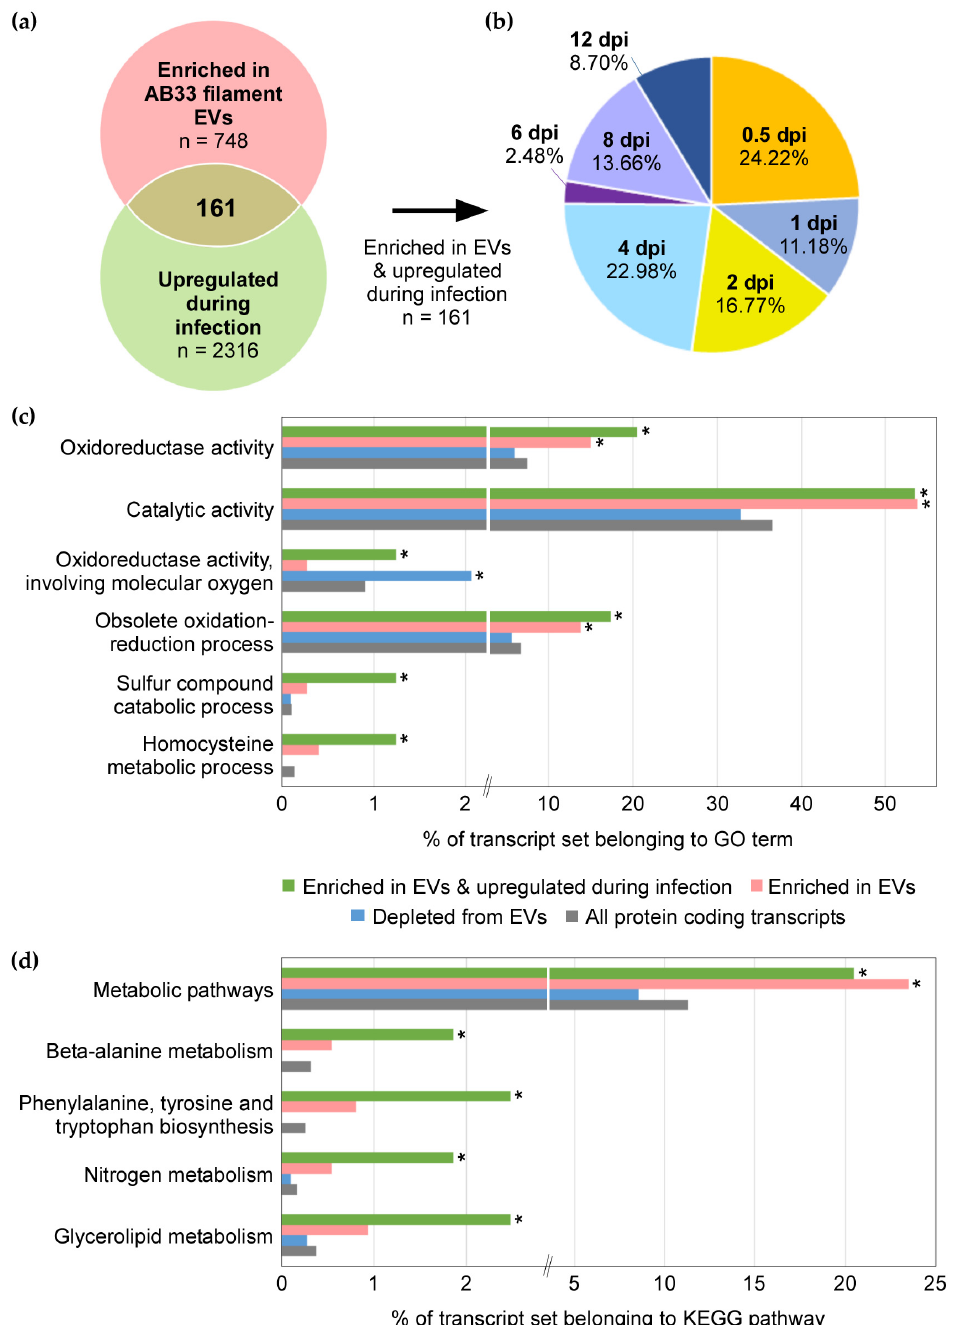
Figure 6. mRNAs enriched within EVs and upregulated during infection. ( a ) Overlap between transcripts enriched within EVs of induced filaments and those upregulated during plant infection. Pink circle represents mRNAs enriched in EVs relative to induced filaments are from this study (n = 748, Log2 fold change ≥ 1, padj < 0.01, baseMean ≥ 10). Green circle represents are mRNAs upregulated in infectious hyphae at 0.5–12 days post inoculation compared to axenic sporidia at 0 dpi (n = 2316, Log2 fold change ≥ 1, padj < 0.01; original data from Lanver et al. [56]). ( b ) Pie chart showing peak expression time-points of 161 mRNAs both upregulated during infection and enriched in EVs. ( c ) GO terms and ( d ) KEGG pathways overrepresented in sets of transcripts enriched in EVs and upregulated in plants (green; n = 161), all enriched in EVs (pink; n = 748, baseMean ≥ 10, Log2 fold change ≥ 1, padj < 0.01), all depleted from EVs (blue; n = 1113, baseMean ≥ 10, Log2 fold change ≤ − 1, padj < 0.01), and all protein coding transcripts known in U. maydis (grey; n = 6765). Asterisk indicates significant overrepresentation compared to all protein coding transcripts (g:SCS padj < 0.05).